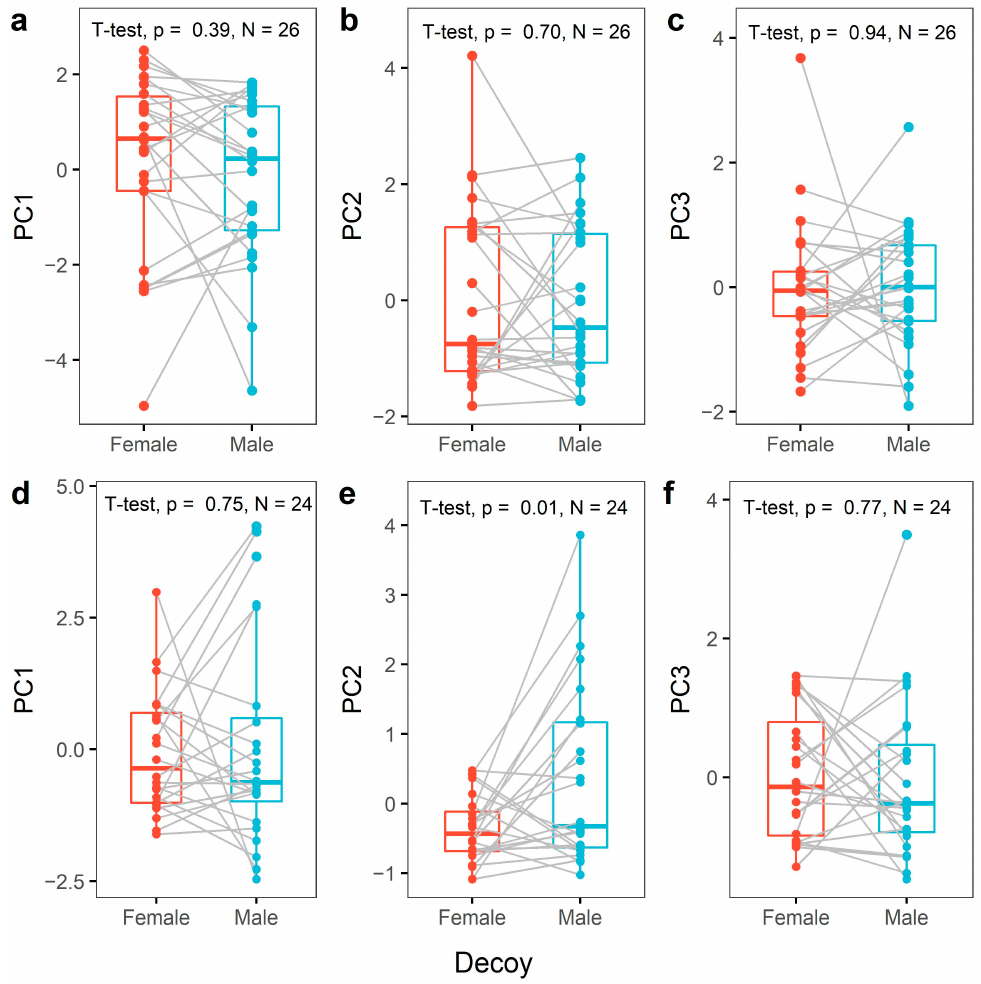
Figure 1. Paired boxplots showing the level of aggression during trials with a female or a male decoy. Female aggression scores based on PC1 ( a ), PC2 ( b ) and PC3 ( c ) and male aggression scores based on PC1 ( d ), PC2 ( e ) and PC3 ( f ) are shown. The grey lines show the difference in individual aggression scores between trials.